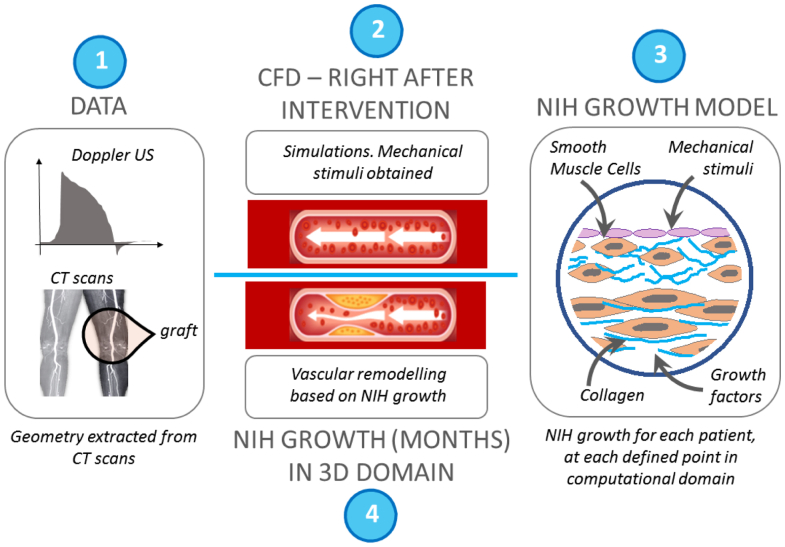
A schematic diagram of the framework for simulating neointimal hyperplasia (NIH) progression. 1, Clinical data are extracted for each patient (eg, computed tomography [CT] scans, Doppler ultrasound [US] images) and processed for computational fluid dynamics (CFD) simulations. 2, CFD simulations are performed right after the intervention, obtaining mechanical stimuli and calculating hemodynamic stress indices (eg, time-averaged wall shear stress [TAWSS], oscillatory shear index [OSI], highly oscillatory, low magnitude shear [HOLMES]). 3, Simulations of a biochemical model of NIH growth and progression. 4, Simulations of NIH growth for a long time span in the three-dimensional (3D) domain.